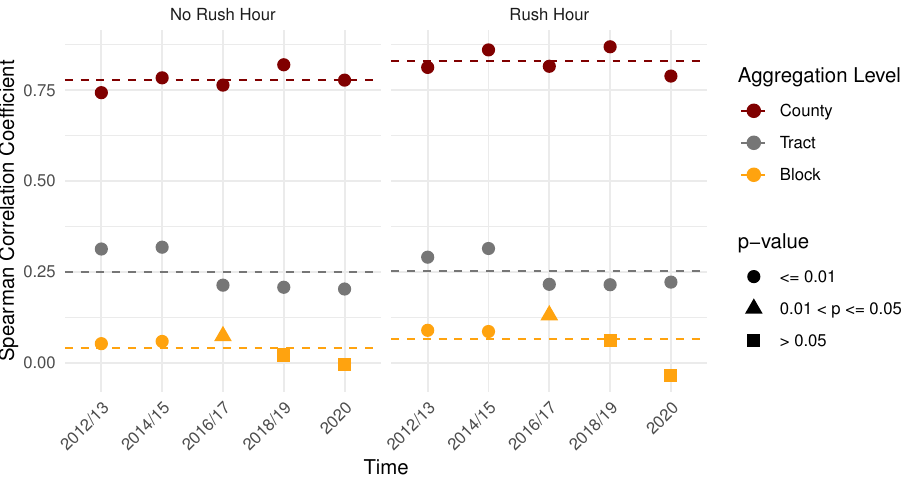
Figure 6. Correlation coefficients between Twitter and LODES flows between regions. The mean of correlation coefficients for the spatial scale levels is indicated with a dashed